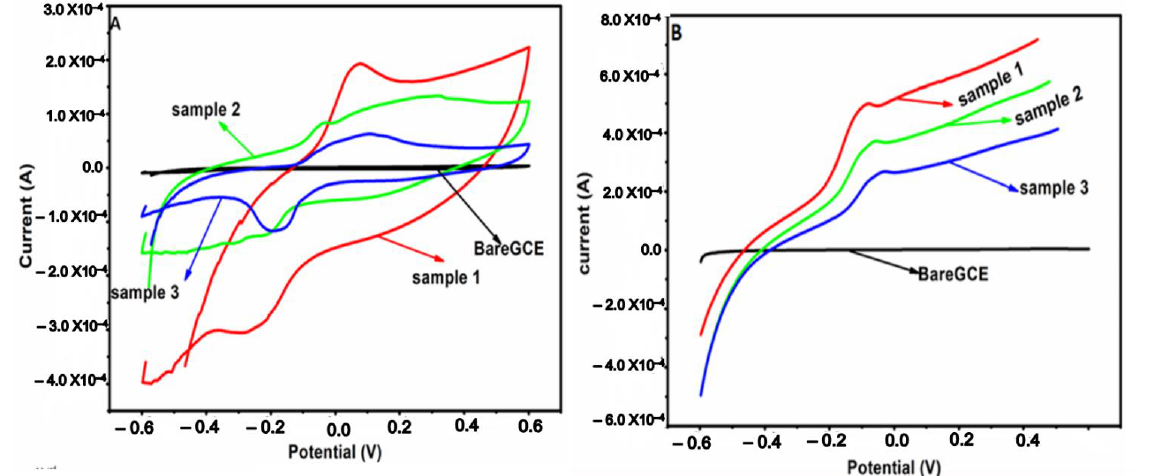
Figure 7. Cyclic ( A ) and linear ( B ) voltammetry curves of bare GCE and modified A: GCE/ CuO- TiO 2 30/70 (S1) B: GCE/ CuO-TiO 2 50/50 (S2): GCE/ CuO-TiO 2 70/30 (S3) in 0.5 M H 2 SO 4 as an electrolyte.